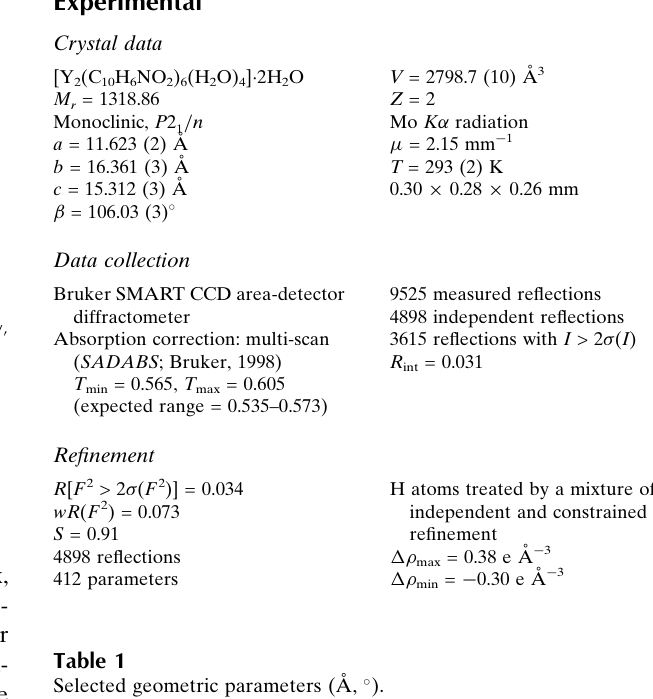
centrosymmetric binuclear complex, coordinated by nine O atoms from five ligands and two water molecules in a slightly distorted monocapped square-anti- Selected geometric parameters (A˚ , (cid:2) ). prismatic coordination environment. The Y III atoms are separated by a distance of 4.0363 (9) A˚ . The ligands coordinate in three different modes: chelating, bridging and a mixed chelating bridging mode. In the crystal structure, the binuclear complexes are linked by O—H (cid:1) (cid:1) (cid:1) O and O—H (cid:1) (cid:1) (cid:1) N hydrogen bonds, forming a three-dimensional network.